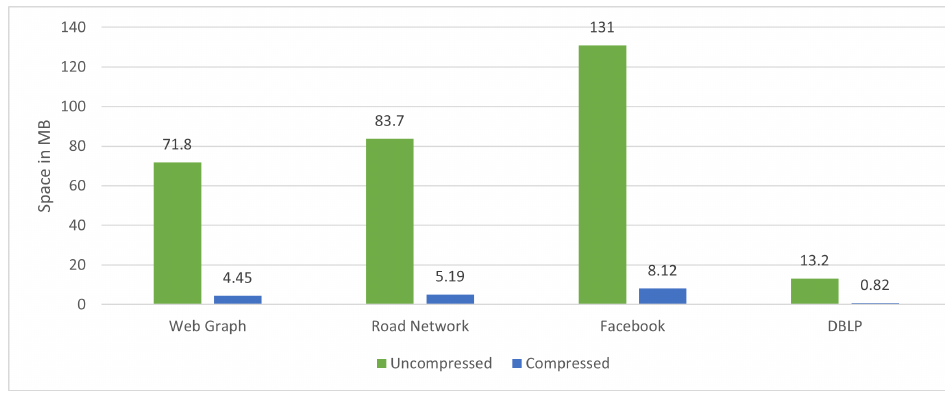
Figure 9. Uncompressed and compressed data on